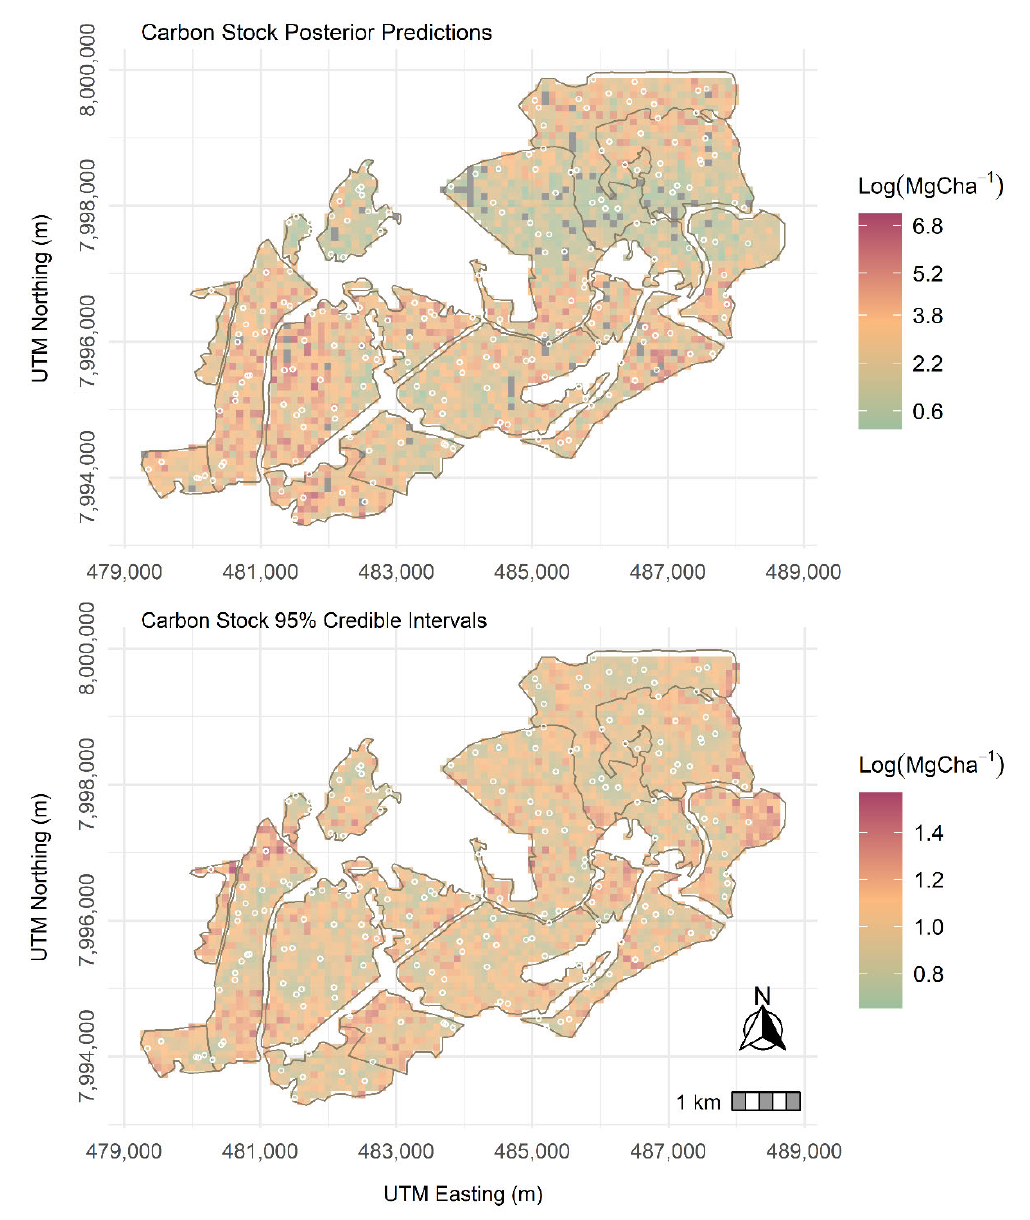
Figure 5. Landsat ‐ 8 ‐ based C stock posterior